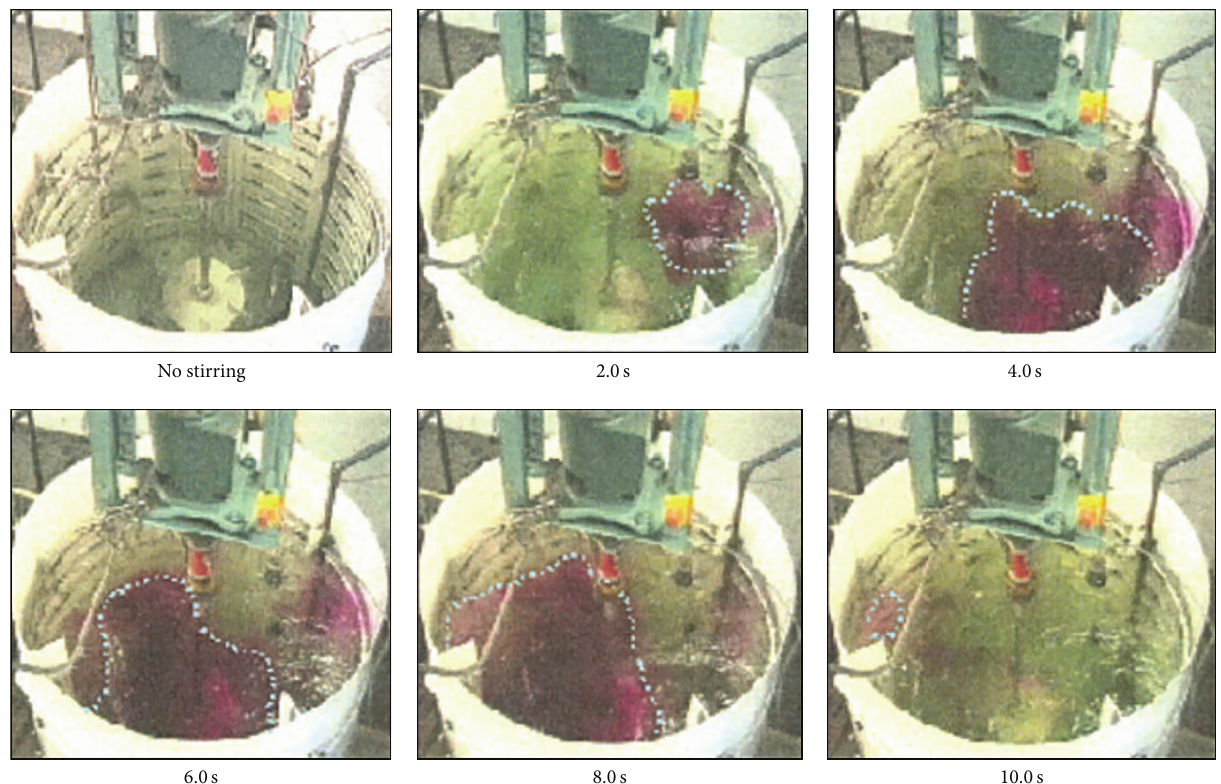
Figure 4: Visualized acid-alkali reactive tracer mixing using the caustic soda-hydrochloric acid-phenolphthalein system conducted by Wabo et al. 2004 [25].